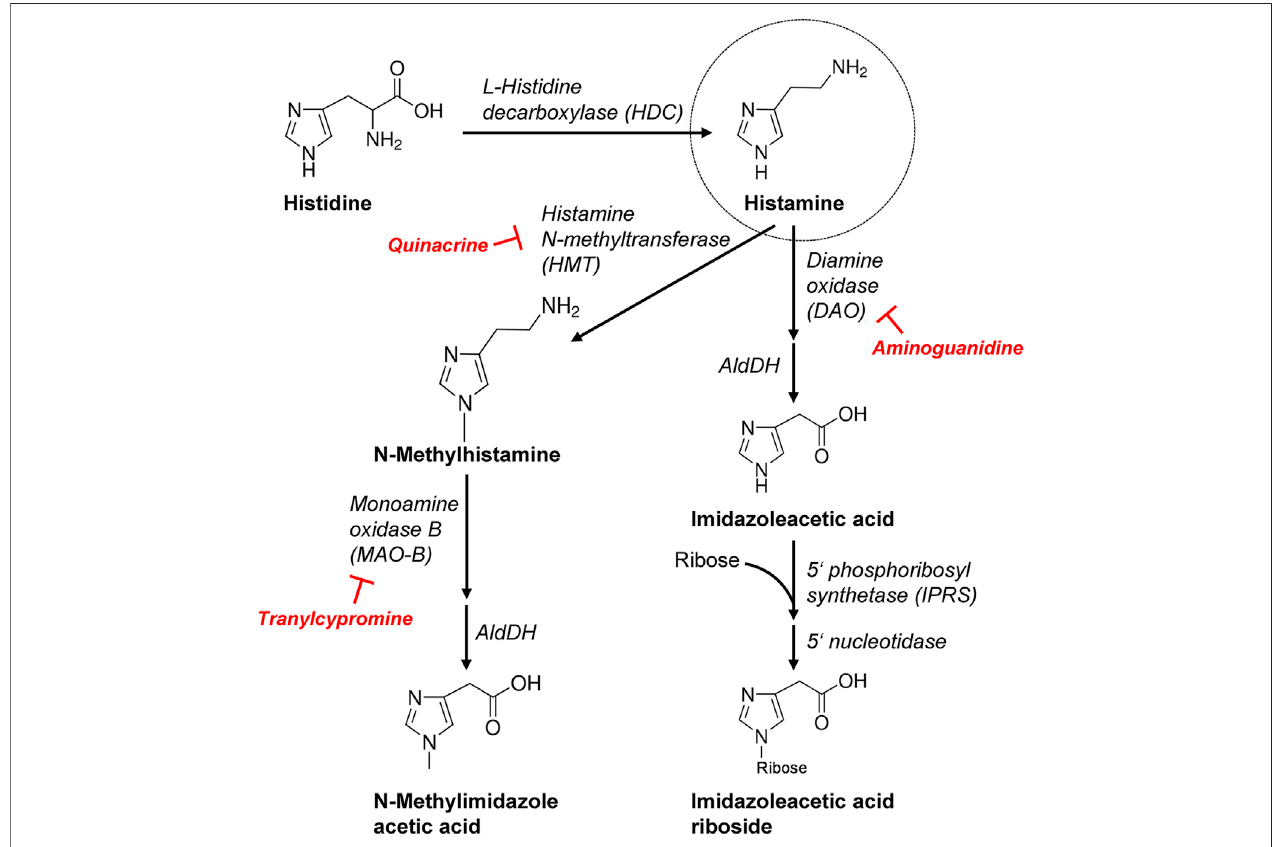
FIGURE 2 | More detailed schematic presentation of histamine synthesis and degradation. Important enzymes involved are mentioned and, additionally, the inhibitors used in this study are shown. AldDH, aldehyde dehydrogenase.